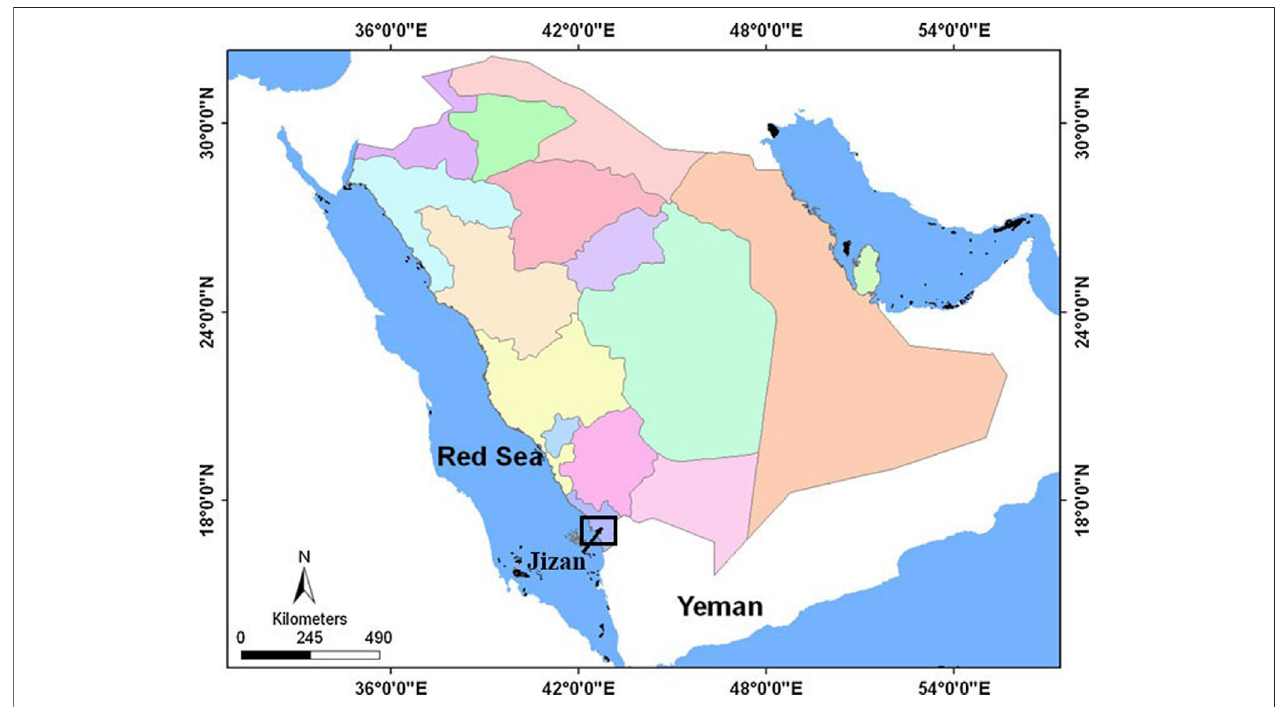
FIGURE 1 | Location map of the study